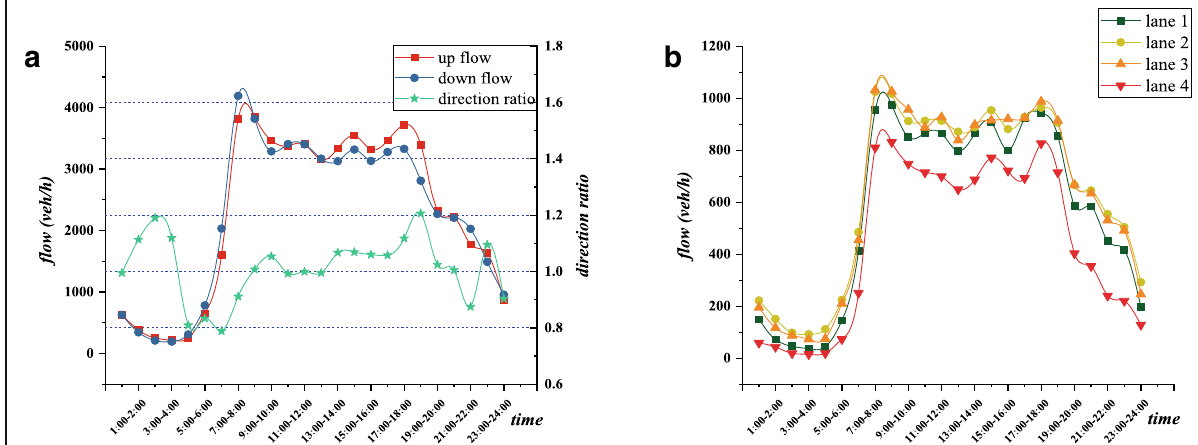
Fig. 9 Flow direction distribution and flow lane distribution of Qingnian